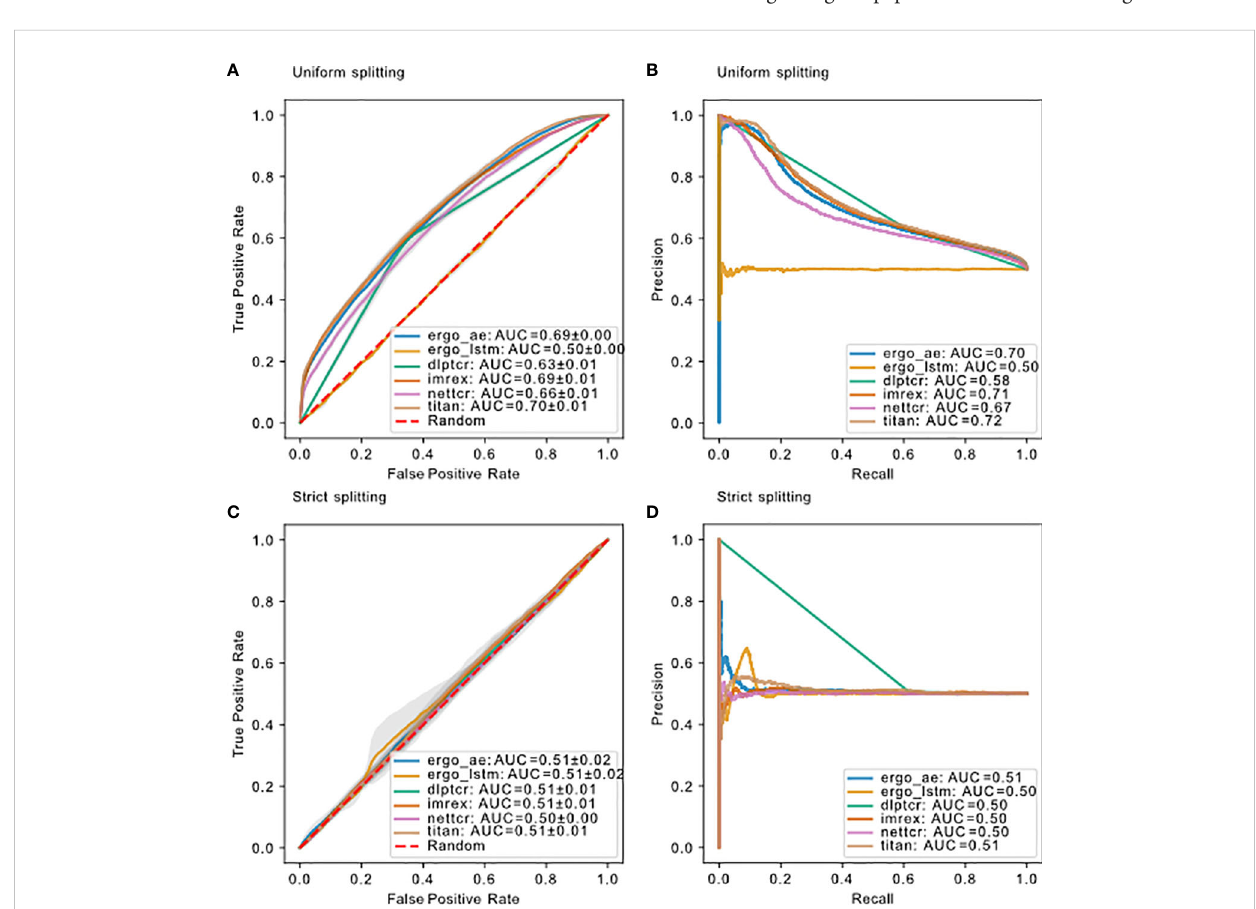
FIGURE 5 Model performance on d base using different splitting methods. (A) ROC curve and (B) PR curve for models using uniform splitting. (C) ROC curve and (D) PR curve for models using strict splitting. The dashed red lines indicate performance of random guessing. ROC and PR curve for DLpTCR looks “ linear ” , because DLpTCR outputs a binary and not a continuous